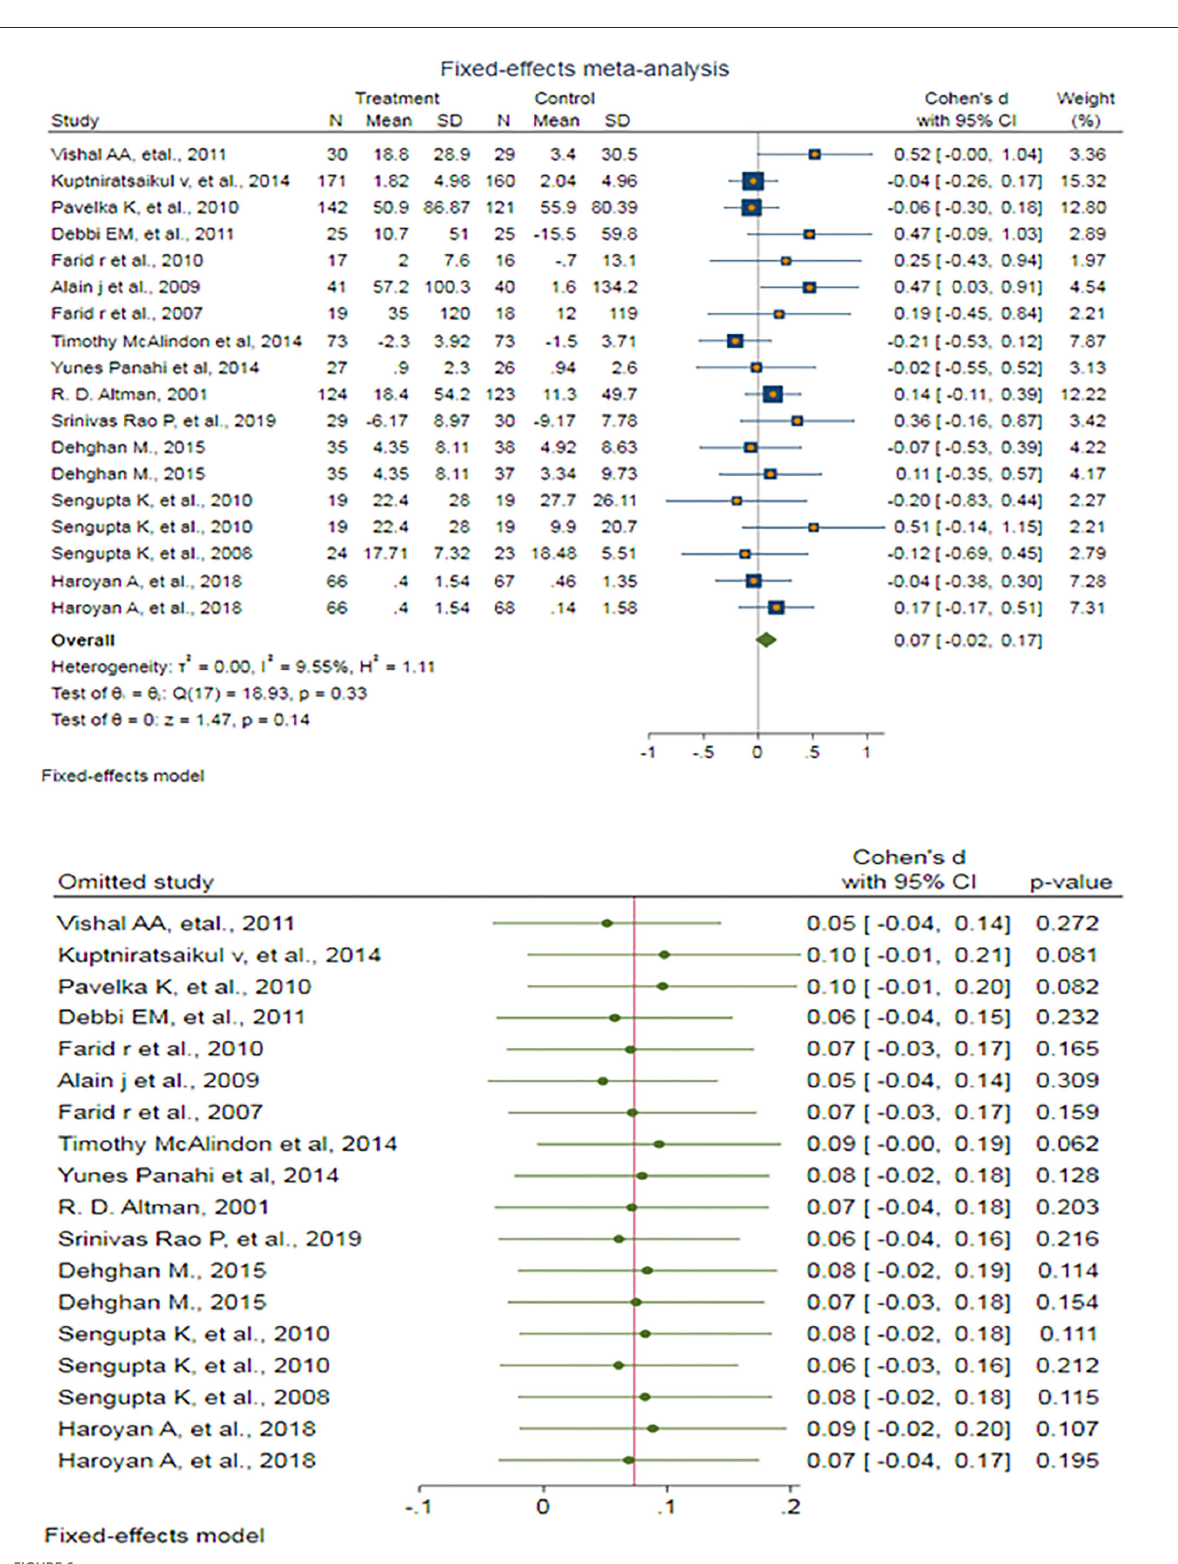
FIGURE6 (UP) A forest plot for the association between antioxidants and the outcomes of interest in OA based on the WOMAC stiffness score. (DOWN) Forest plot of sensitivity analysis for the association between antioxidants and the outcomes of interest in OA based on the WOMAC stiffness